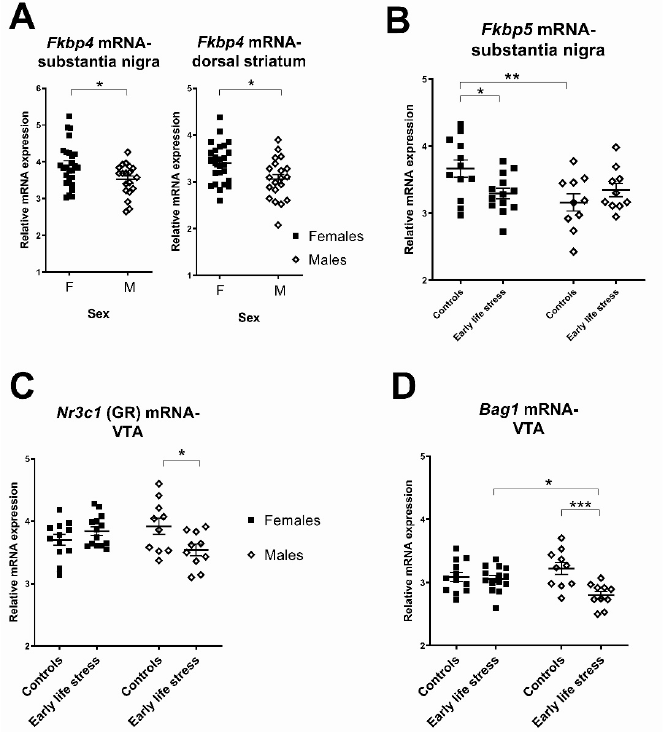
Figure 3. Differences between females and males in stress-related transcript levels and effects of early life stress. ( A ) Females had significantly higher Fkbp4 mRNA levels in the substantia nigra and dorsal striatum than males; ( B ) female control rats had higher Fkbp5 mRNA levels in the substantia nigra than male control rats. They also had higher Fkbp5 mRNA levels than maternally separated female rats; ( C ) maternally separated male rats had lower Nr3c1 (GR) mRNA levels in the VTA than male control rats; ( D ) maternally separated male rats had lower Bag1 mRNA levels in the VTA than male control rats. Each data point represents a single animal. Filled squares and hollow diamonds represent female and male animals, respectively. Horizontal lines depict group means. * p < 0.05, ** p < 0.005, *** p < 0.0005.